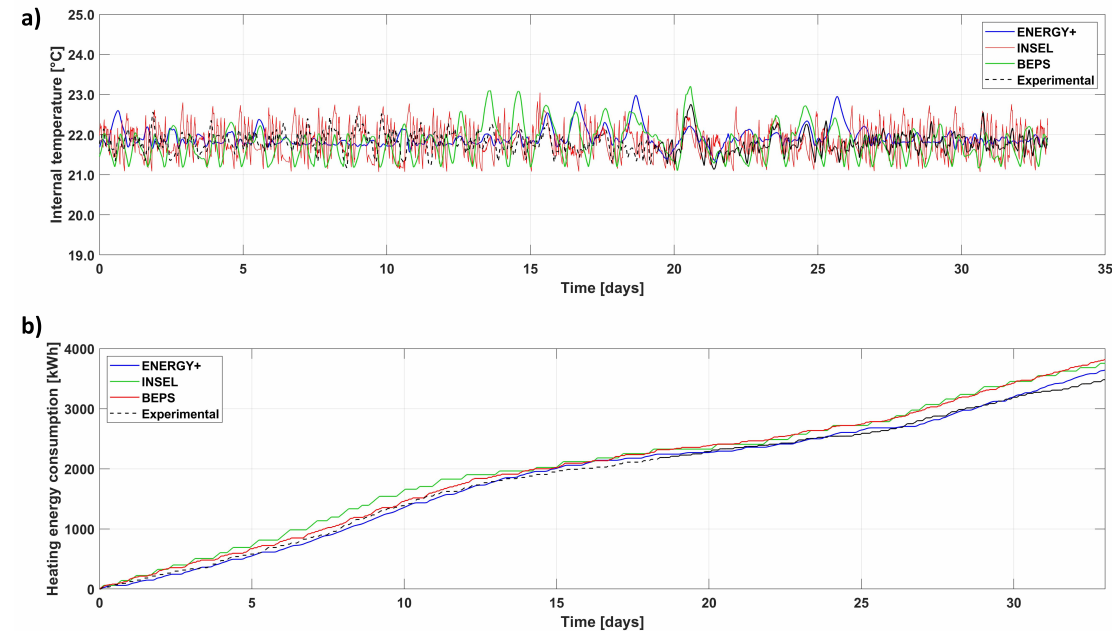
Figure 8. ( a ) Comparison between internal temperature profiles from E+, INSEL and BEPS and experimental data. ( b ) Cumulative building heat demand in the period considered.